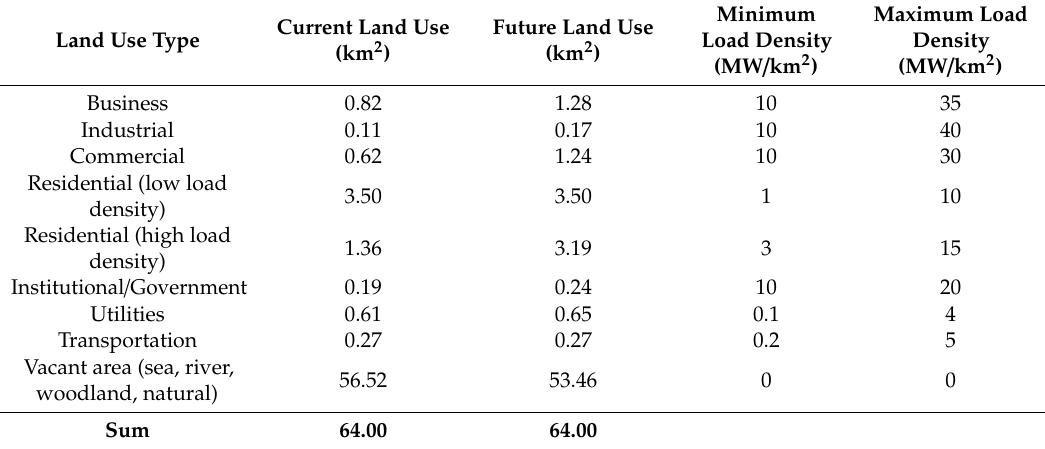
Table 1. Land use types of the service